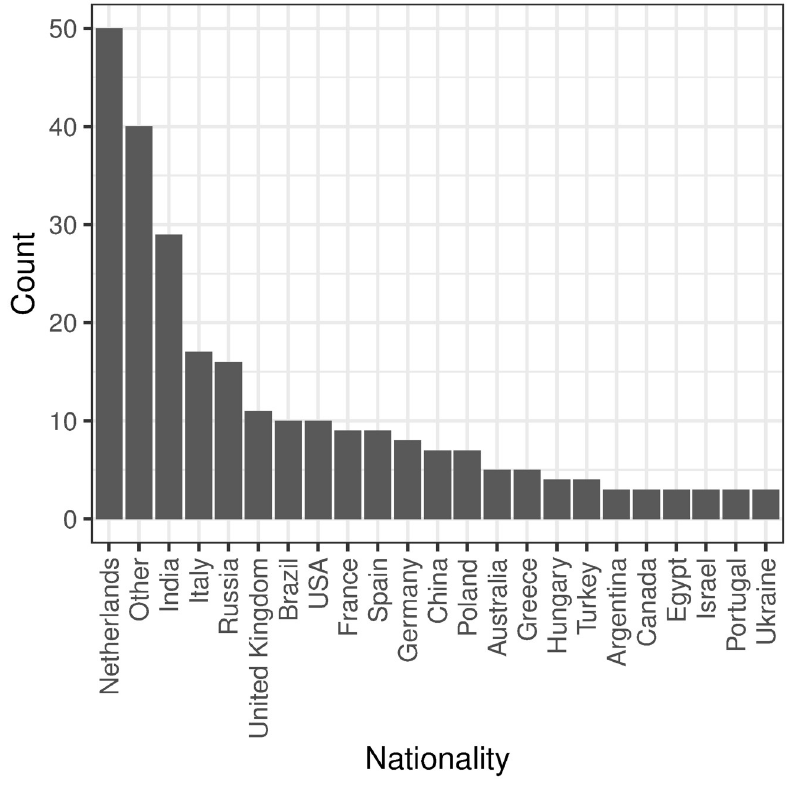
Fig 1. Nationality of